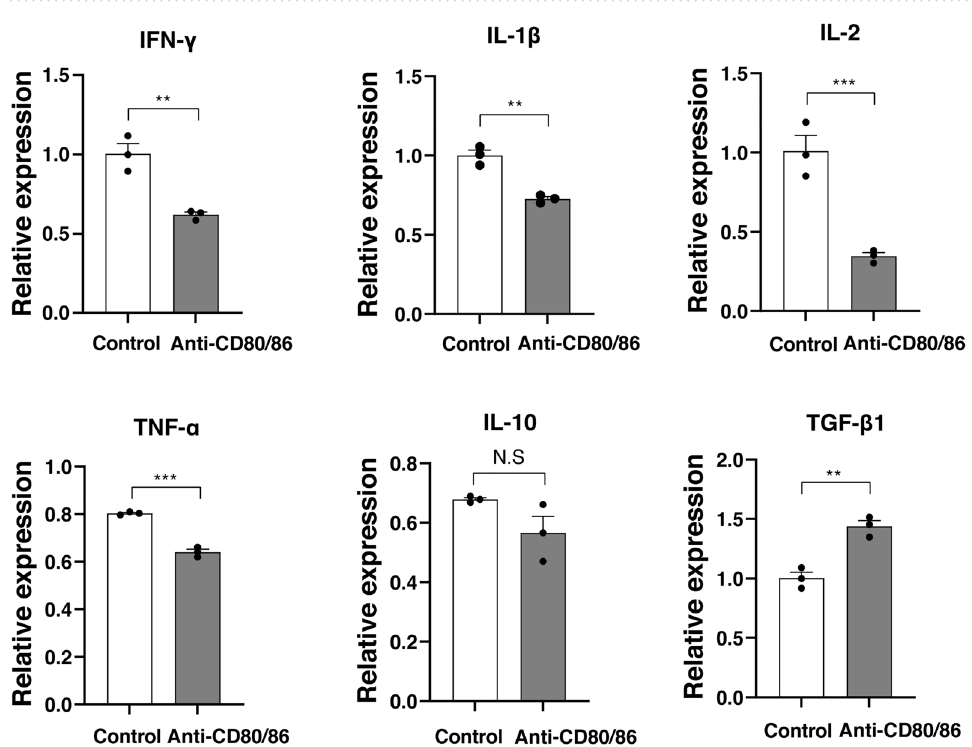
Figure 5. Anti-CD80/86 antibodies regulate cytokine expression in the corneal grafts. The relative mRNA expression of IFN-γ was downregulated in the anti-CD80/86 injection group compared with that in the phosphate-buffered saline (PBS) group (n = 3, N.S no significant difference, ** P = 0.005). IL-1β was downregulated in the anti-CD80/86 injection group compared with that in the PBS group (n = 3, ** P = 0.002). IL-2 was downregulated in anti-CD80/86 injection group compared with that in the PBS group (n = 3, ** P = 0.003). TNF-α was downregulated in the anti-CD80/86 injection group compared with that in the PBS group (n = 3, *** P < 0.001). There was no difference in IL-10 between the anti-CD80/86 injection group and the PBS group (n = 3, N.S, P = 0.111). TGF-β1 was upregulated in the anti-CD80/86 injection group compared with that in the PBS group (n = 3, ** P = 0.003). An unpaired t- test was applied for all statistical